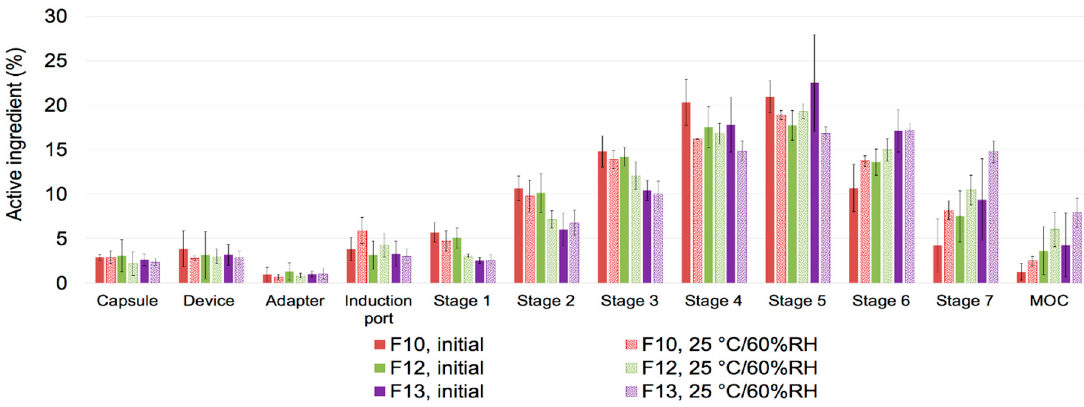
Figure 7. Aerosol performance of TFF remdesivir powder formulations after one month of storage at 25 °C/60% RH when emitted from a Plastiape ® RS00 high-resistance DPI at a flow rate of 60 L/min ( n